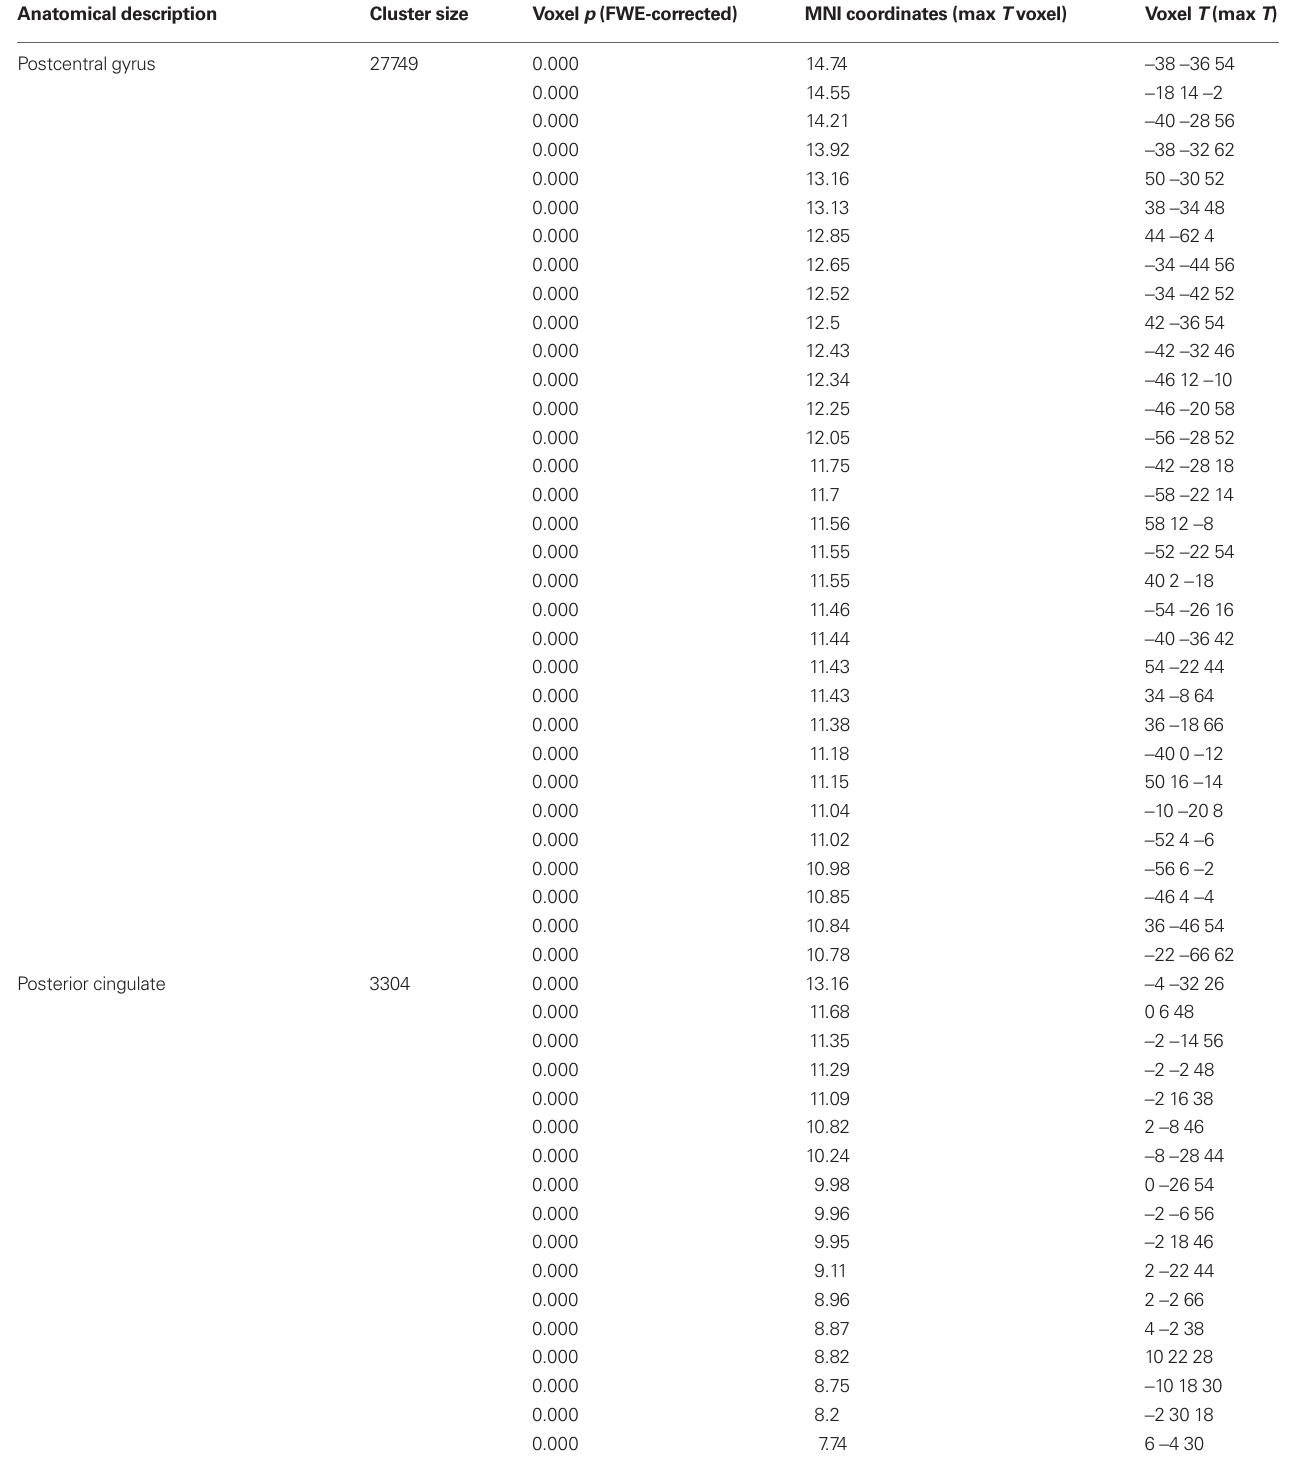
Table a1 | Complete list of local maxima within clusters activated for the contrast stimulation versus baseline (as illustrated in Figure 2). anatomical